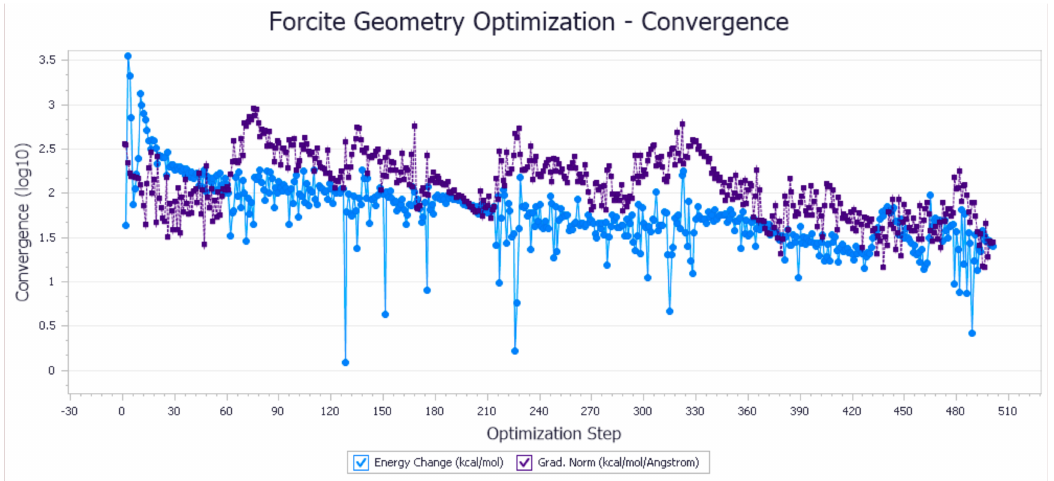
Figure 5. Demulsifier2 # oil–water interface geometric optimization steps.